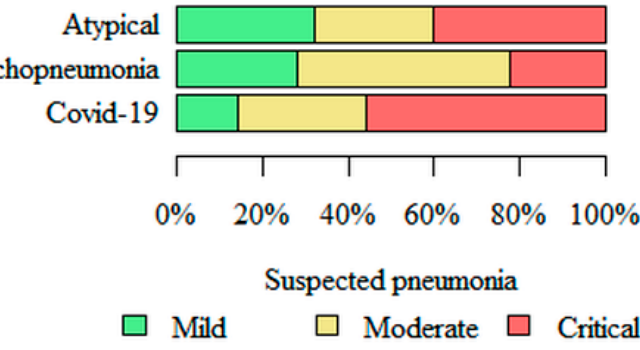
Figure 7. Comparison of the estimated risk of pneumonia, based on HRCT images, in three subgroups of pneumonia.